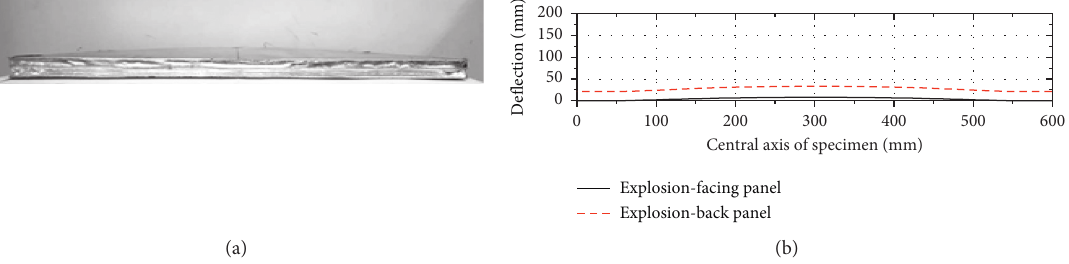
Figure 21: Side deformation and deflection of ST4. (a) Side view of ST4 deformation situation. (b) ST4 deflection data curve.